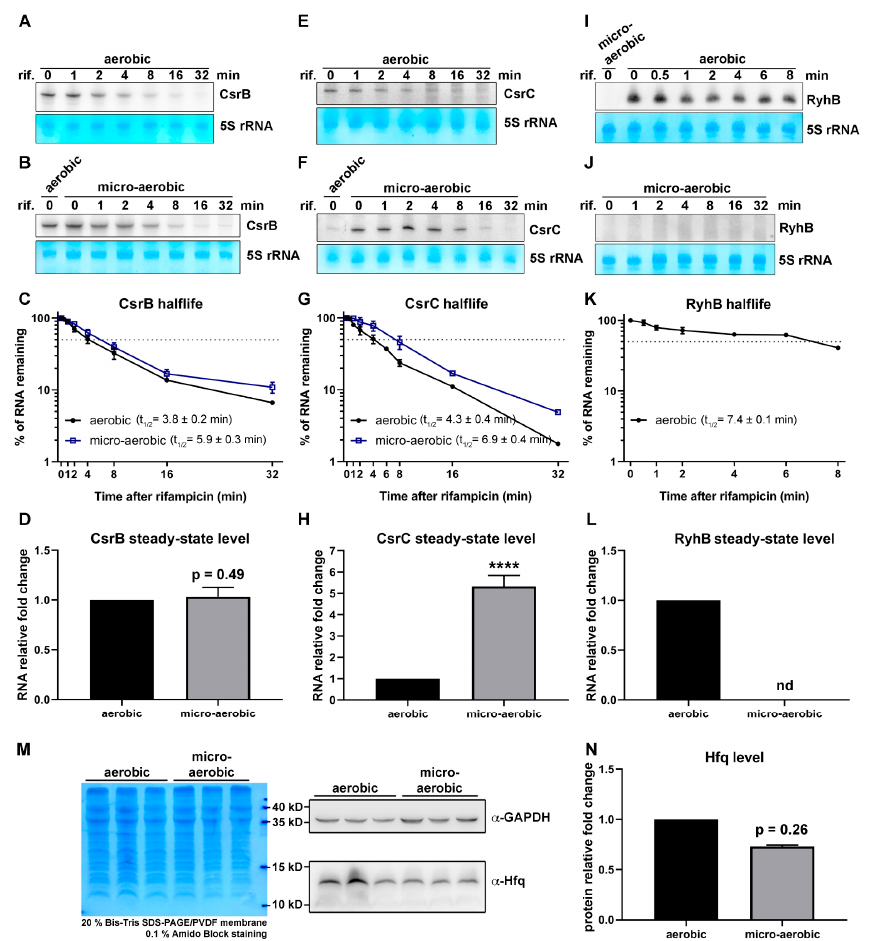
(left and middle panels, respectively) and csrA (right panel) mRNAs within the E. coli genome. The y axis represents the number of RNA-seq reads for the sRNAs and csrA mRNA on the largest scale of 400,000 and 4000, respectively. The coding region of each gene is shown in blue at the top of each panel, and expression is shown in blue and red for aerobic and microaerobic growth conditions, respectively.